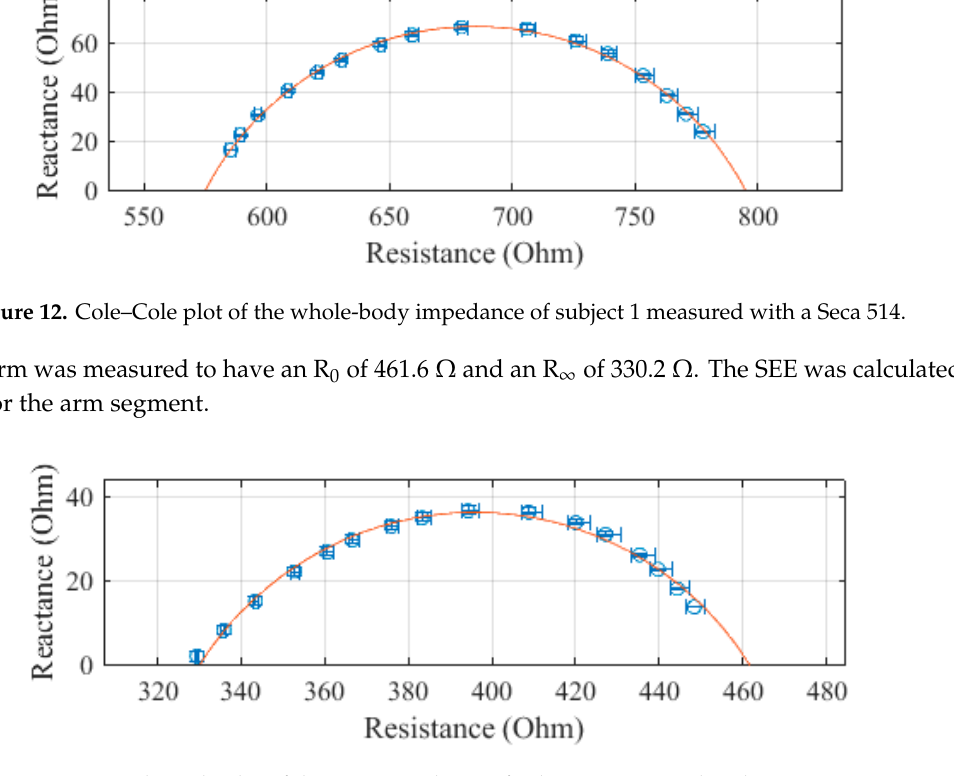
Figure 13. Cole–Cole plot of the arm impedance of subject 1 measured with a Seca 514.